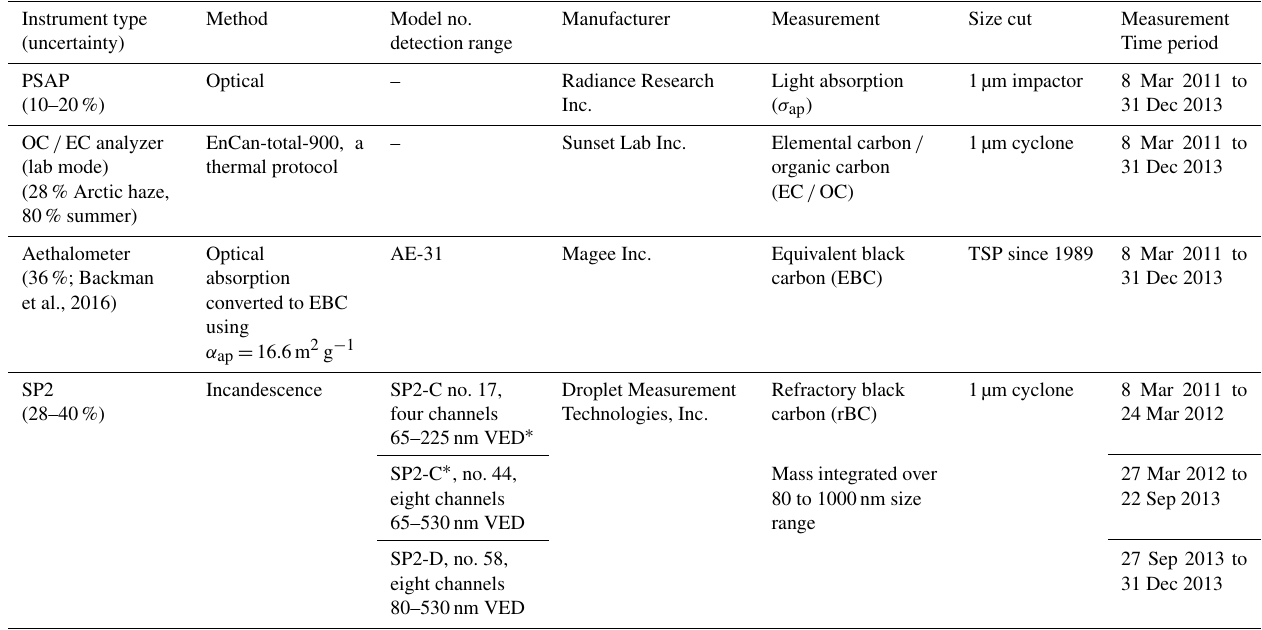
Table 1. Various instruments used in this comparison study.